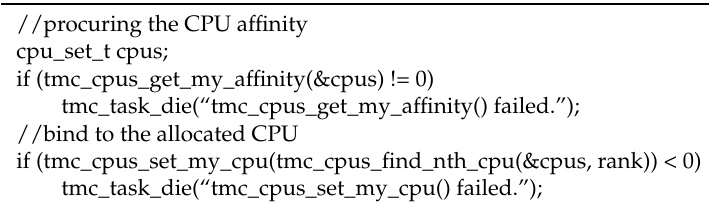
Table 2. The details of the CPU affinity.